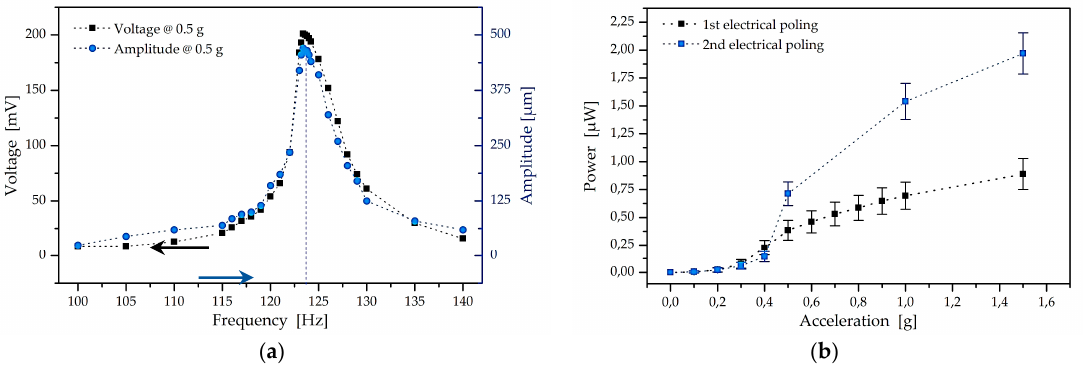
Figure 3. ( a ) Peak-to-peak voltage and amplitude as a function of frequency at 0.5 g acceleration for the harvester structure from Figure 1a; ( b ) Generated power as a function of acceleration after the 1st and the 2nd PZT poling